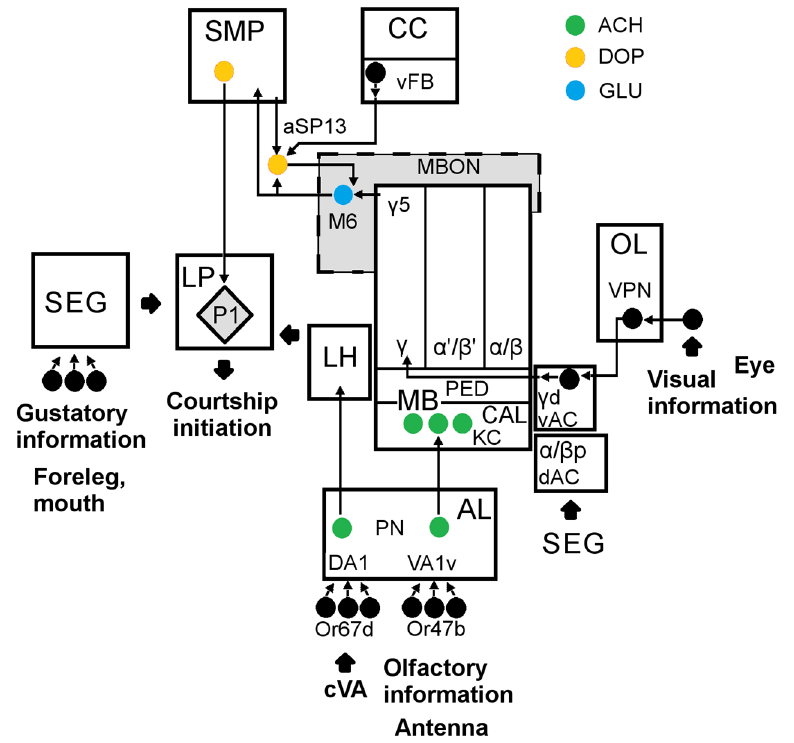
Figure 10. The simplified scheme of the Drosophila brain structures regulating courtship and memory formation in conditioned courtship suppression paradigm (CCSP). Abbreviations are given in text. Nerve cell bodies are shown as circles. Specific neurotransmitters are shown by colors.